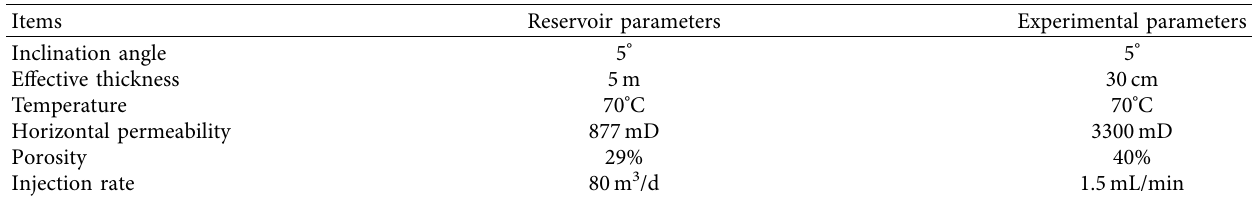
Table 1: Experimental